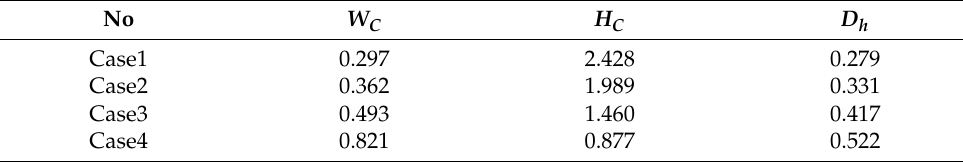
Table 5. Parameters of triangular microchannel heat sinks ( A C = 0.36 mm 2 unit: